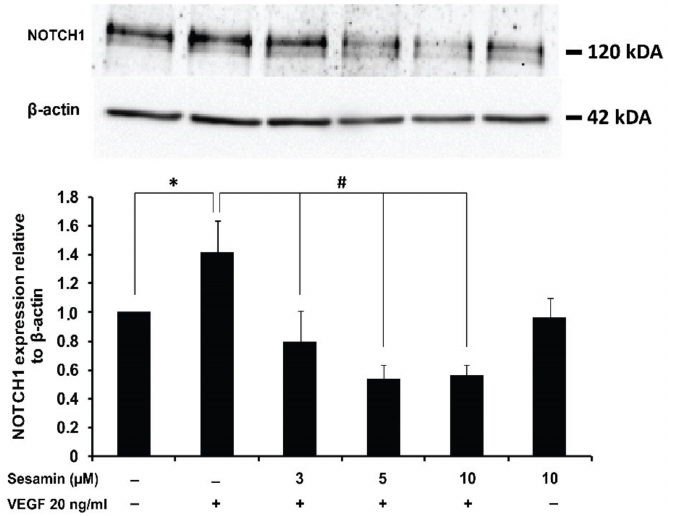
Figure 6. The effect of sesamin on NOTCH1 expression in human endothelial cell line,